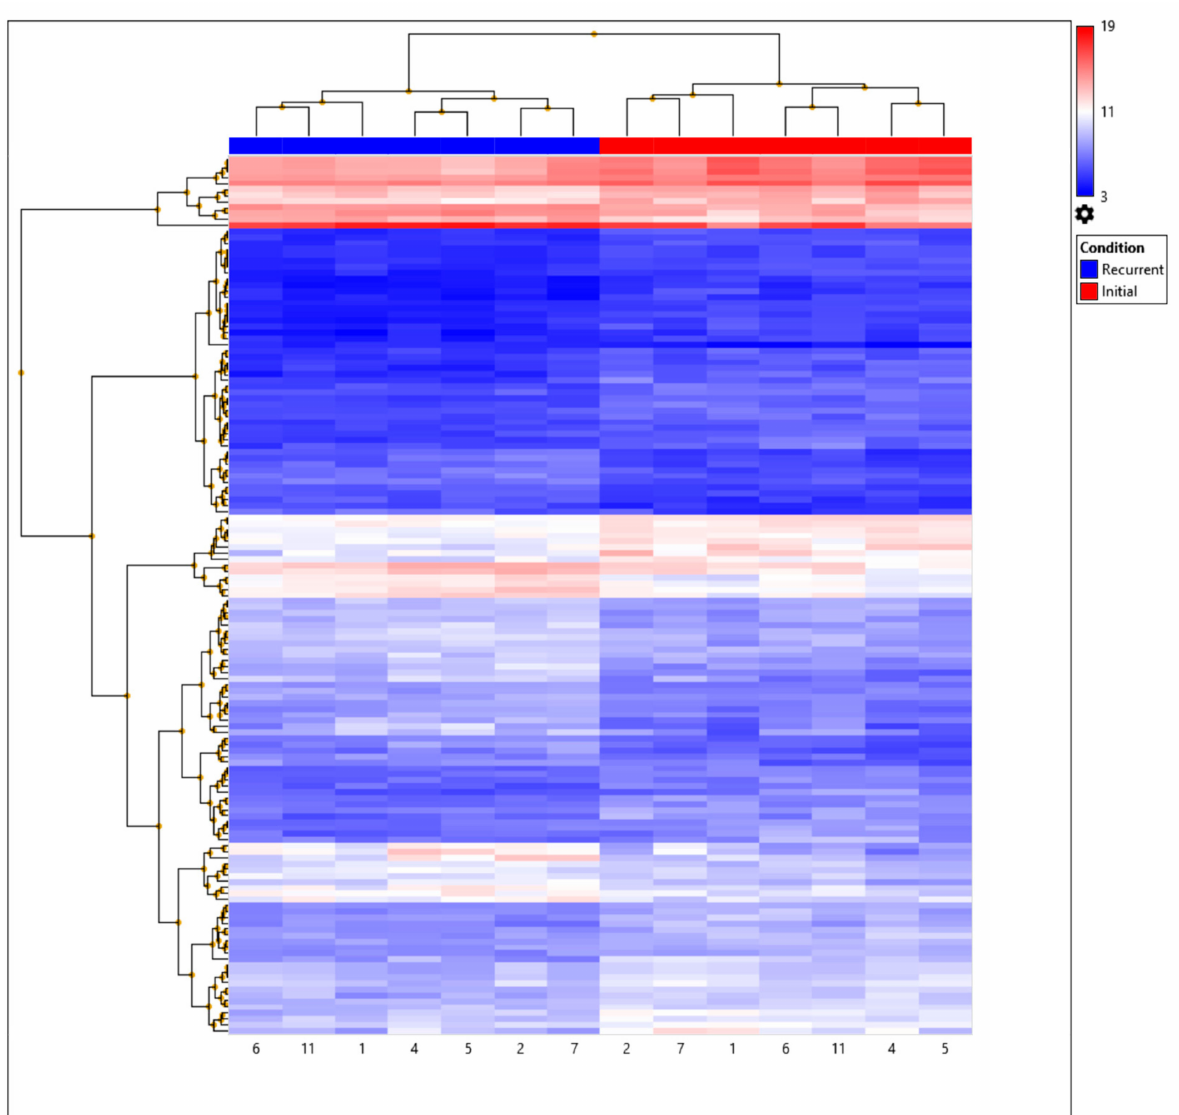
Figure 1. Hierarchical clustering of GBM IDH-wildtype samples based on the expression of the 147 differentially expressed probes or genes (DEGs). Expression (Log 2 ) is displayed on a scale from high (red) to low (blue) values. Patient sample IDs of initial (red) and recurrent (blue) are displayed at the bottom of the